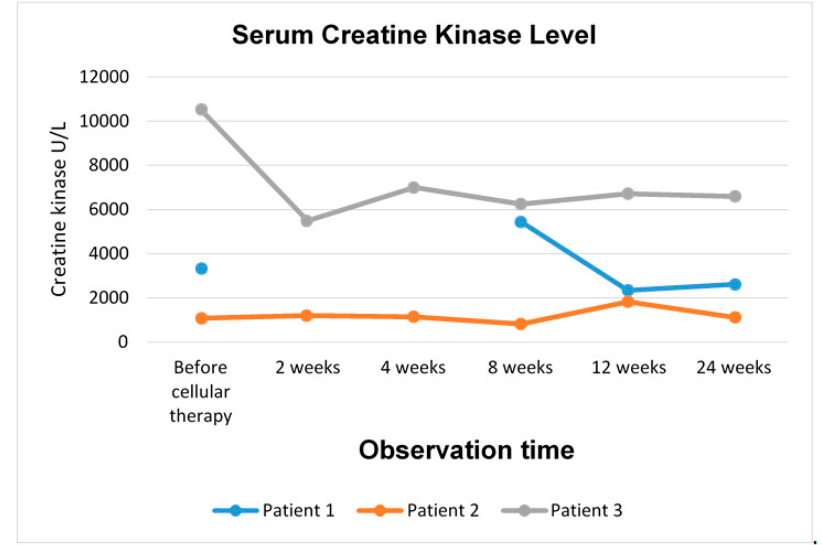
Figure 1. Creatine kinase level in DMD patients after cellular therapy with BM-MSCs and myogenic stem/progenitor cells.